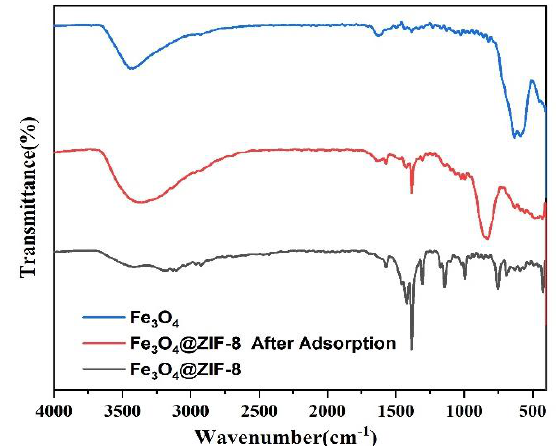
Figure 10. FTIR pattern of synthesized Fe 3 O 4 , Fe 3 O 4 @ZIF-8.